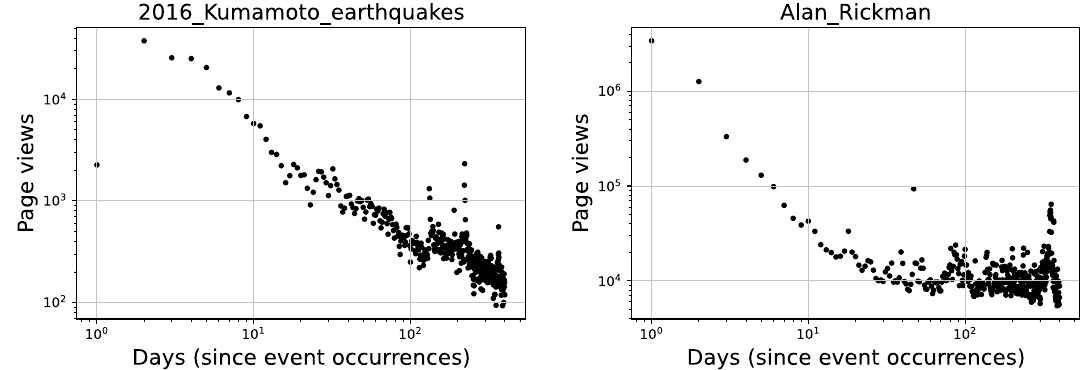
Figure 1. Examples of daily Wikipedia page view decay for 400 days in log-log scale. The panels show page views decay after an event occurrence in 2016: Kumamoto earthquake (left) and the death of Alan Rickman (right). In Alan Rickman’s case, there is a spontaneous increase of page views around 365 days.